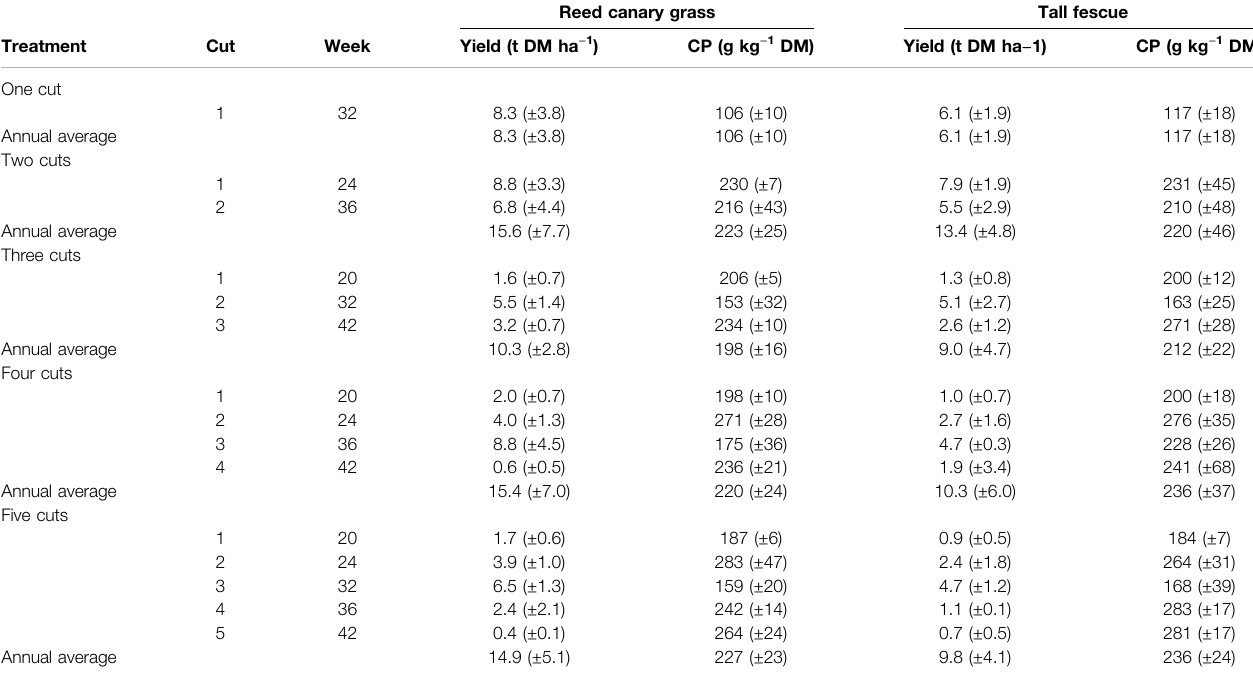
TABLE 1 | Total annual average biomass yields in dry matter (t DM ha − 1 ) and averaged crude protein (CP) contents (g kg − 1 DM) per harvest and treatment for reed canary grass and tall fescue. Standard deviation is giving in brackets.